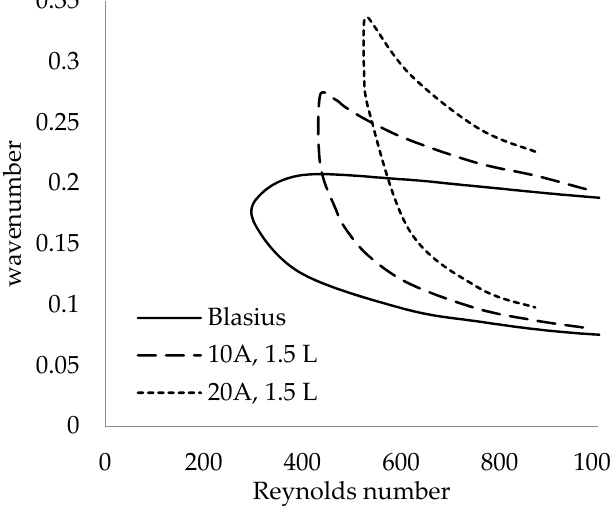
Figure 13. Neutral curves for different amplitudes at the LE trough.